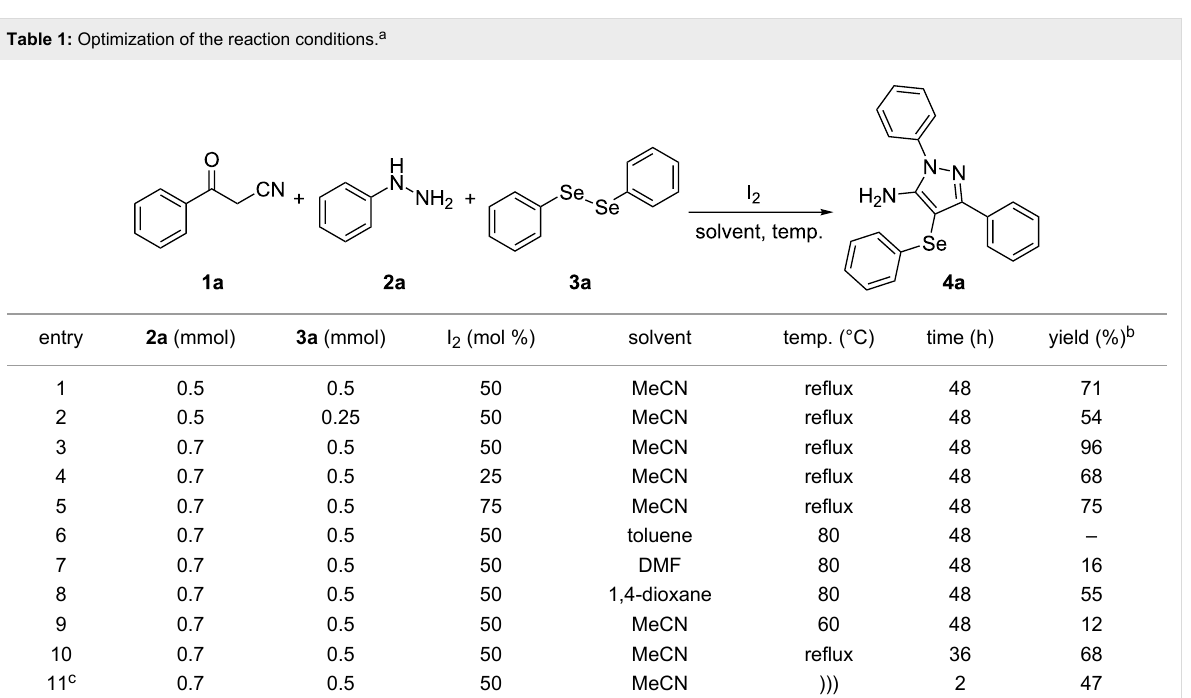
Table 1: Optimization of the reaction conditions.